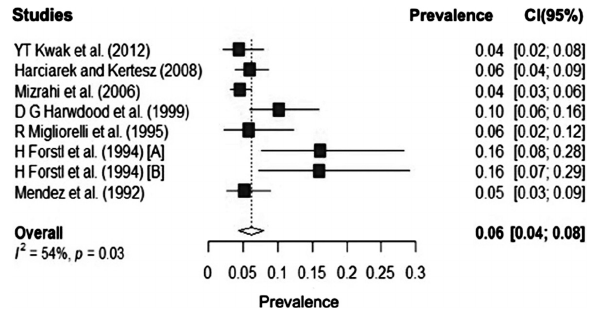
Figure 2. Prevalence of Capgras Syndrome in patients with Alzheimer’s